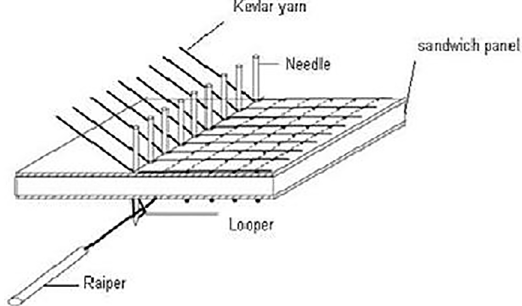
Figure 2. Illustration of multiple needle sewing machine for sandwich composite structures Potluri et al 9 .